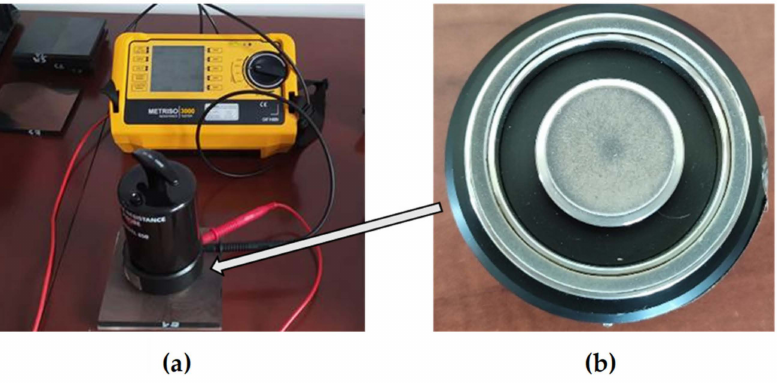
Figure 7. Electrical test stand ( a ) with measuring head ( b ).